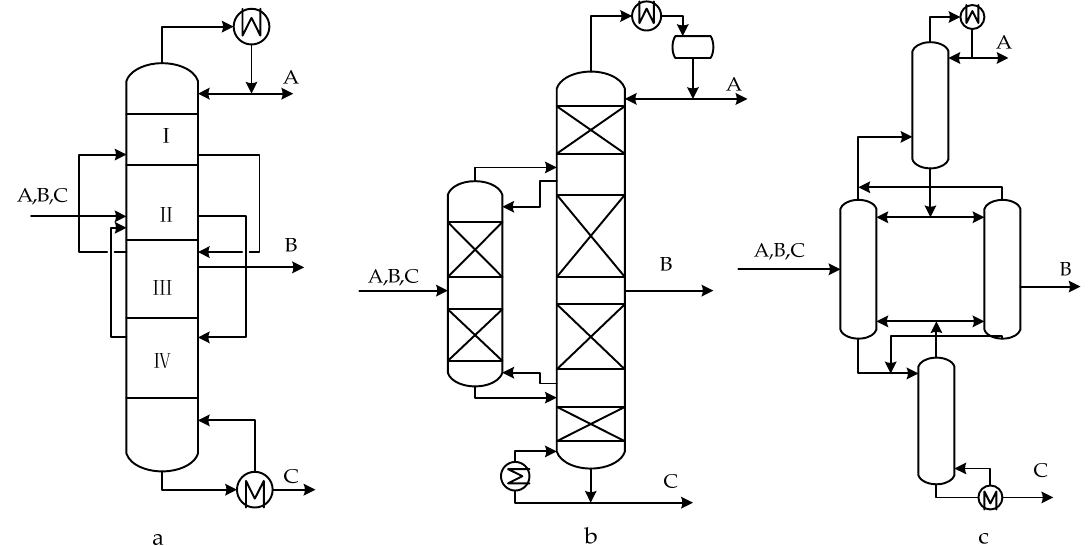
Figure 3. Equivalent column model: ( a ) the pump-around model; ( b ) the two-column sequence model; and ( c ) the four-column sequence model.